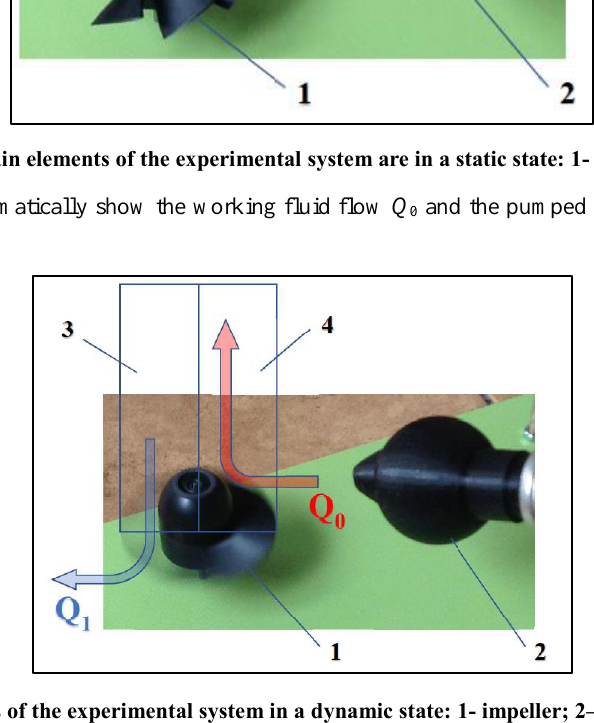
Figure 34. The main elements of the experimental system in a dynamic state: 1- impeller; 2– nozzle; 3- fan operation